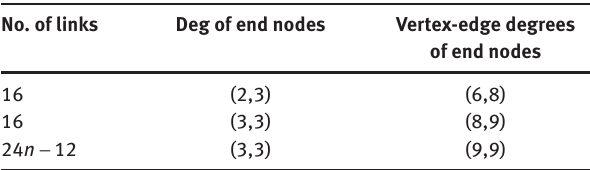
Table 3: The vertex-edge degree of the end nodes of links